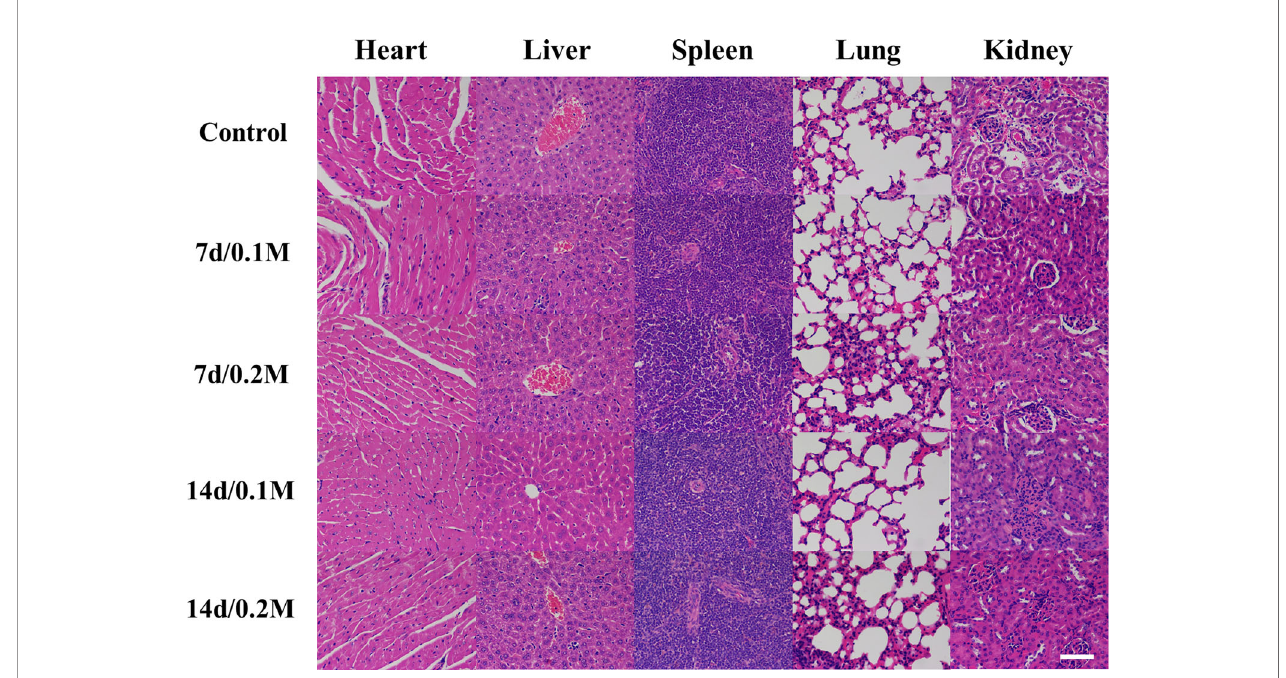
FIGURE 1 | HE staining of main organs (heart, liver, spleen, lung, and kidney) after intravenous administration of 200 m l of different concentrations of Bi-DOTA (0.1 and 0.2 M) after different time points (7 and 14 days) (scale bar: 200 m m).